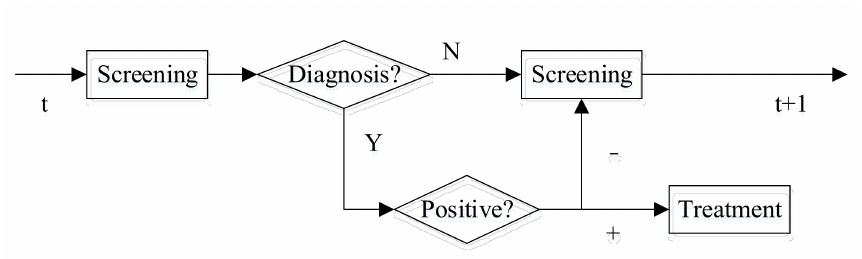
Figure 2. Decision-making process of